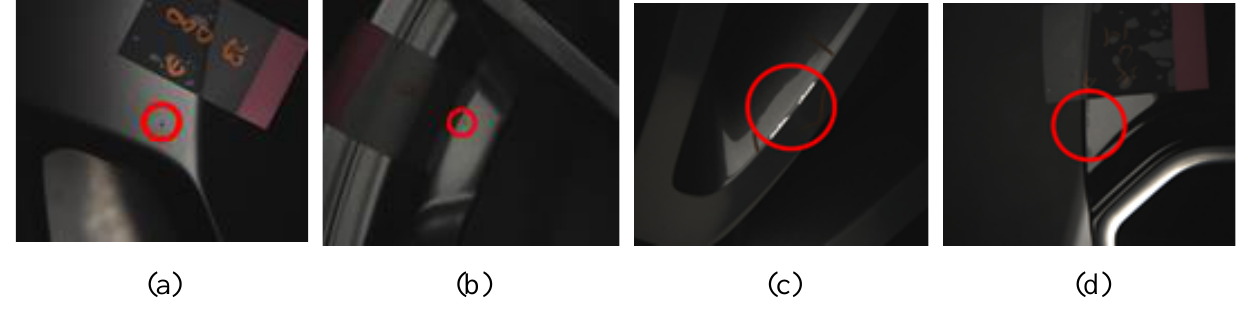
Figure 3. Defects typical of aluminum rims: ( a ) dirt spot, ( b ) paint stain, ( c ) scratch, and ( d ) dent. The imaging system in the current study was based on a color CMOS camera (GS3- U3-51S5C-C; Canada APO Spart) to obtain images at a high sampling rate in real-time (see Table 1). Table 1. Specifications of the industrial camera GS3-U3-51S5C-C.